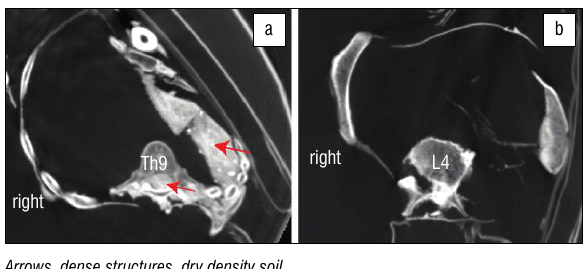
Arrows, dense structures, dry density soil. Note the absence of internal organs. Severely compressed (a) thoracic and (b) abdominal cavities. Both arms were in a flexed position, with the elbow joints intact and showing no degenerative changes. Both knee joints were fully luxated. However, the patello-tibial as well as the proximal tibio-fibular joints remained intact and the right patellar ligament was visible. Both feet were in eversion, with subluxed ankle joints. This position may be the result of tightly flexing the body while wrapping it in the animal skin. Radiodense material was visible in the distal right femur; most likely surrounding soil had entered into the open long bone, but it might also have been liquid material which thickened